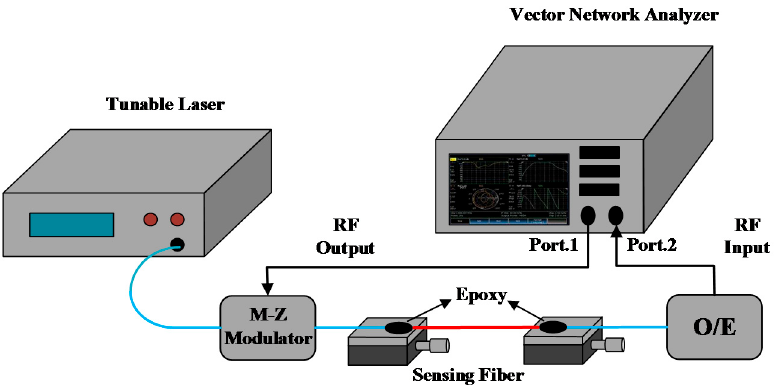
Figure 1. The schematic of the proposed high precision optical fiber delay detection system based on the frequency domain phase method.